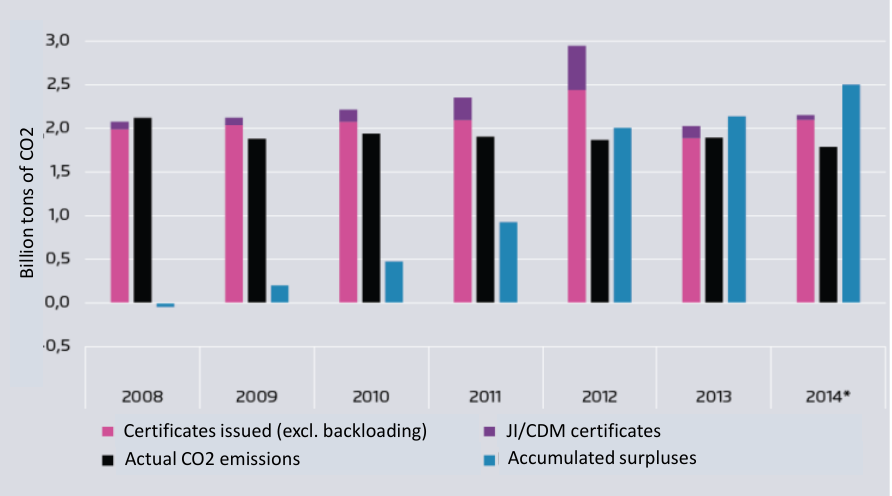
Fig. 3. Development of emissions and surpluses 2008 to 2014 Source: (Agora Energiewende, 2015, p.